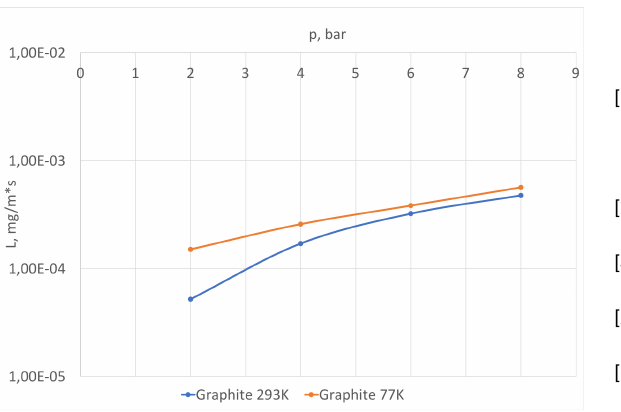
Figure 13: Characteristics of helium leakage from the flanged joint gasketed with the expanded graphite gasket at ambient and 77 K.